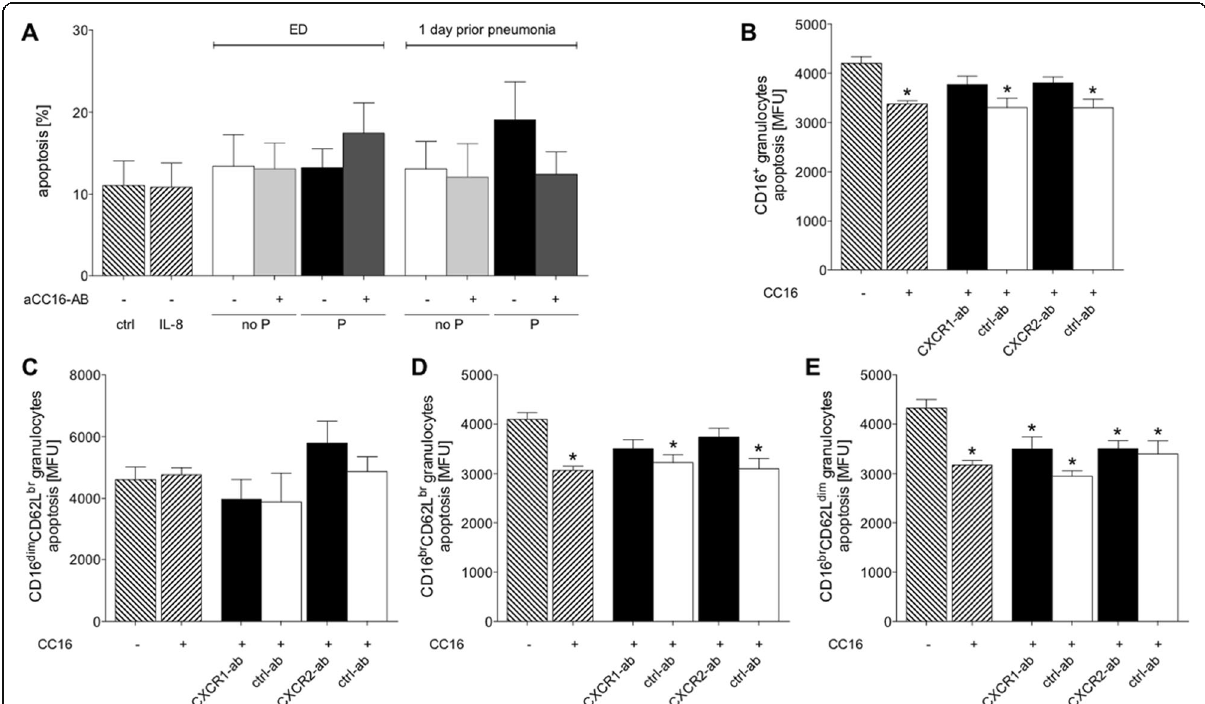
Fig. 5 CC16-reduced apoptosis is not markedly changed by the blockade of chemokine receptors. a Apoptosis of PMNL after their incubation with IL-8 or sera samples from severely injured trauma patients. Patients were grouped to no P group without pneumonia or P group with pneumonia. Samples were obtained at admission to emergency department (ED) and one (Sadeghi-Bazargani et al. 2018) day prior to pneumonia. Samples from the equal post-injury days in the corresponding no P group were used. b Apoptosis in CD16 + granulocytes after incubation with CC16 and neutralization of CXCR1 (CXCR1-ab), CXCR2 (CXCR2-ab) as well the corresponding isotype control antibodies (ctrl-ab), respectively. c Apoptosis of immature CD16 dim CD62L bright , ( d ) mature CD16 bright CD62L bright and ( e ) immunesuppressive CD16 bright CD62L dim granulocytes. Data are represented as mean ± SEM. p < 0.05: *: vs.